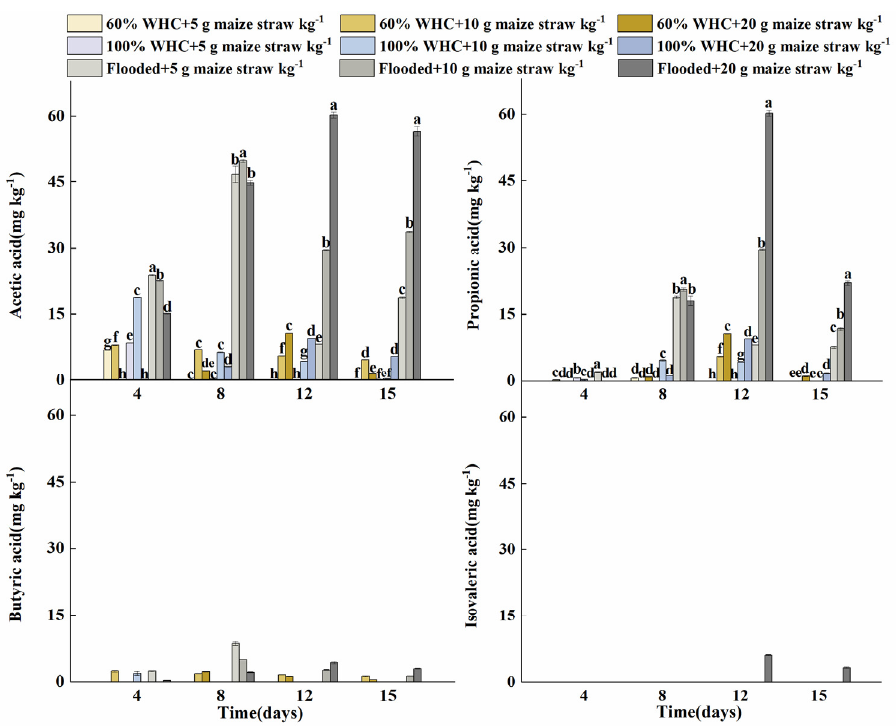
Figure 3. Dynamics of organic acids during the RSD treatments. Error bars indicate standard deviations. Different lowercase letters show significant differences among the various maize straw amended rates and soil water contents. ( p < 0.05). CKs were not displayed in the figure because no organic acid was detected throughout the incubation period.